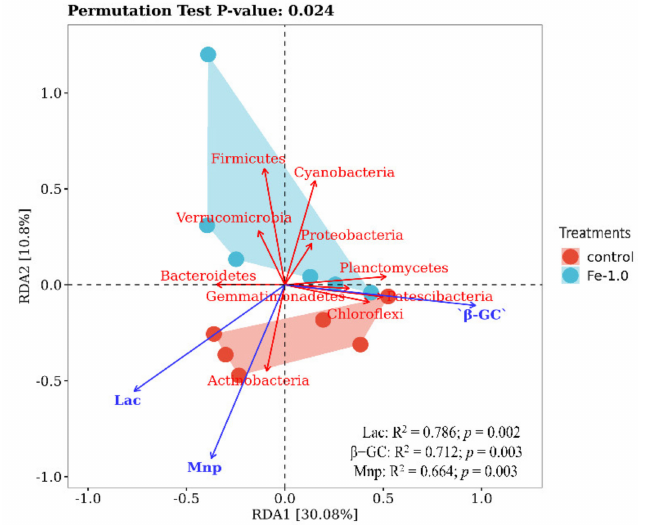
Figure 6. Redundancy analysis depicting the relationship between the bacterial phyla and enzyme activities. The blue and red arrow lengths represent the contribution of enzyme activities and bacterial phyla on the microbial community; R 2 represents the magnitude of the correlation with bacterial community; p indicates the significance of the difference at the 0.05